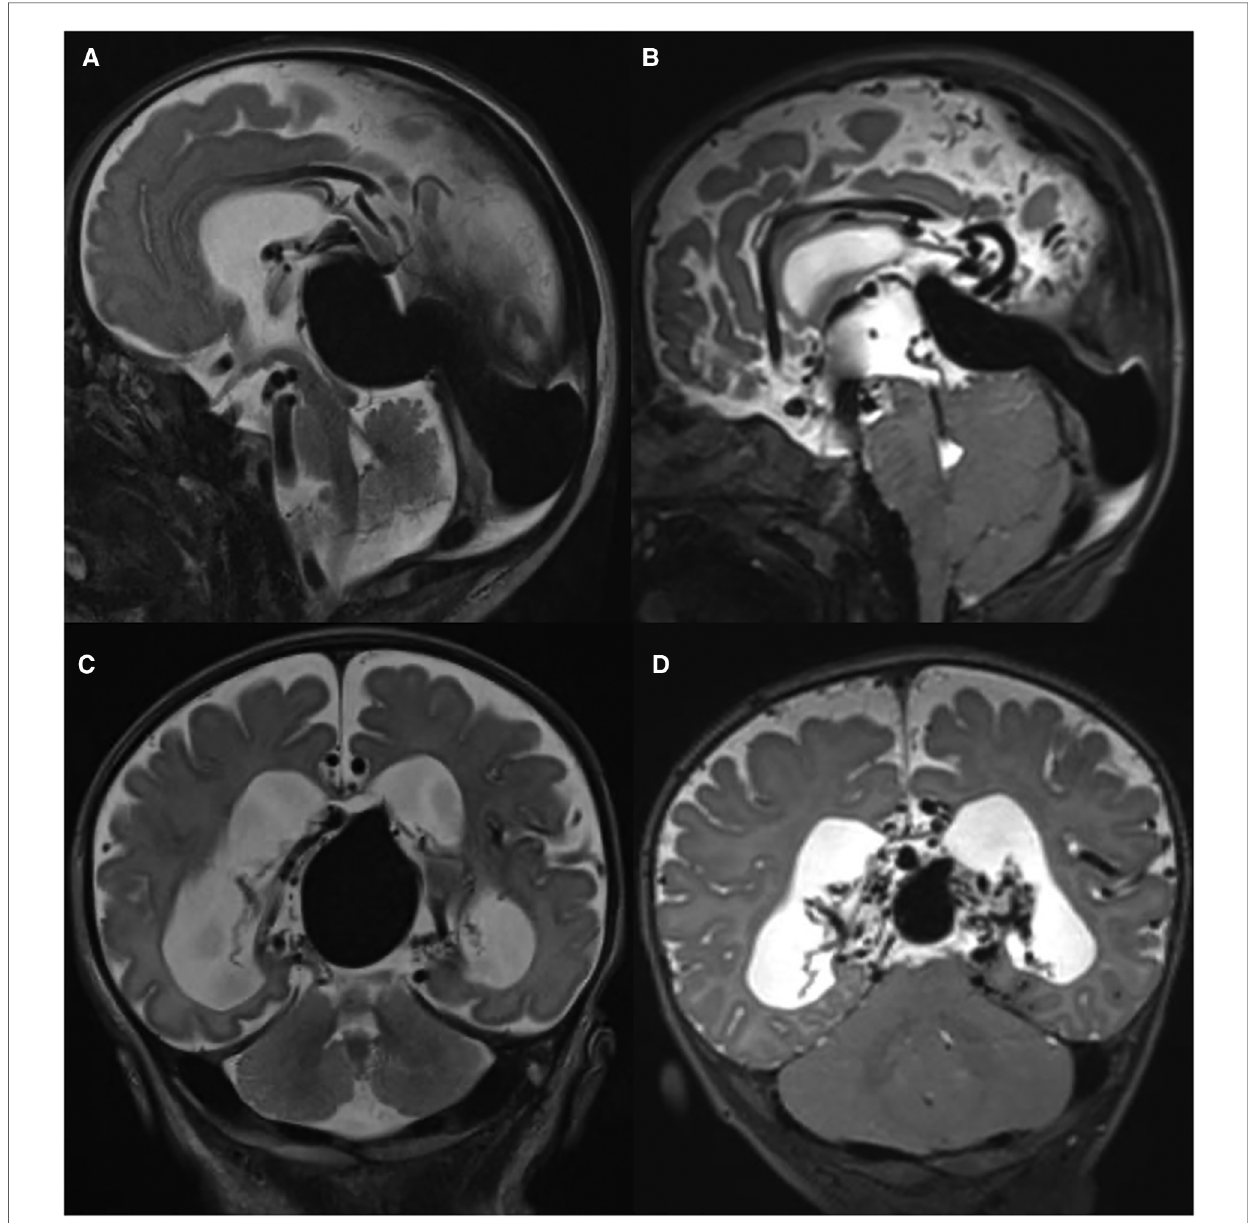
FIGURE 1 Brain MRI features: T2w sagittal ( A,B ) and coronal ( C,D ) images show the presence of VGAM at birth ( A,C ) and after embolization ( B,D ) in patient